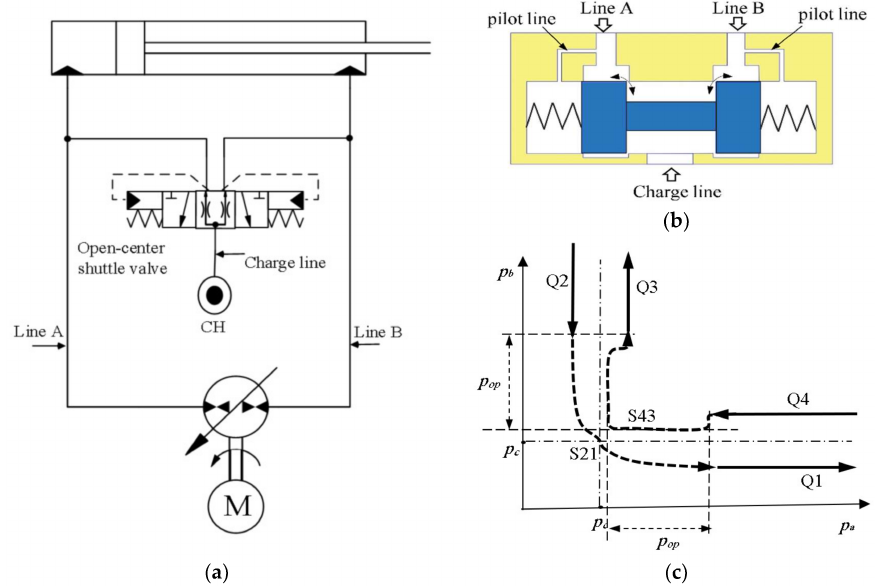
Figure 7. Circuit with open-center shuttle valve to compensate for cylinder differential flow: ( a ) schematic drawing of the circuit; ( b ) drawing of open-center shuttle valve (OC-SHV); ( c ) expected pressure plane performance at critical